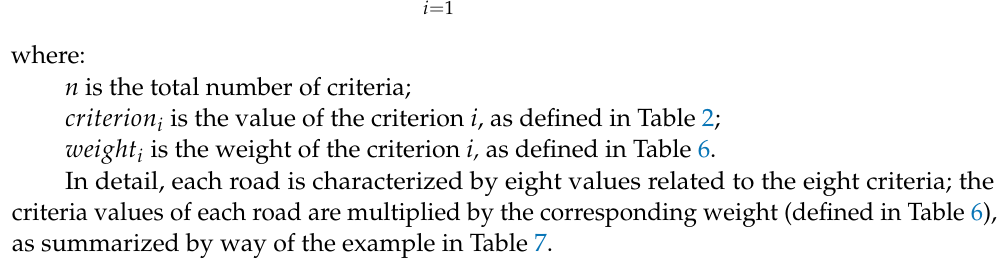
Table 7. Example of the adopted procedure for FI